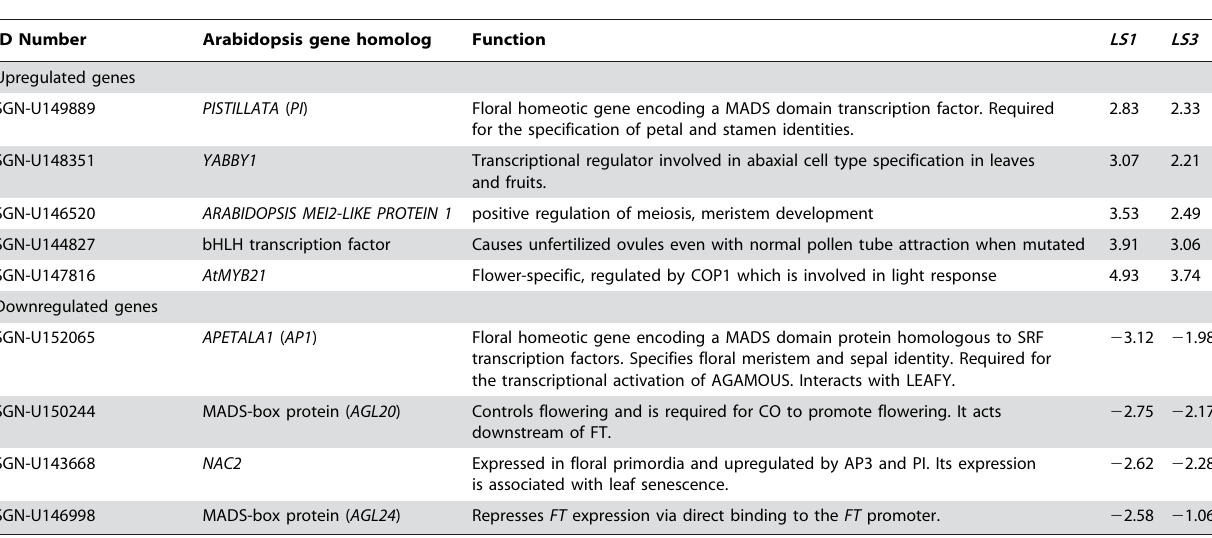
Table 2. Up- and down-regulated flower-related genes in both LS1 and LS3 mutants in tomato.*